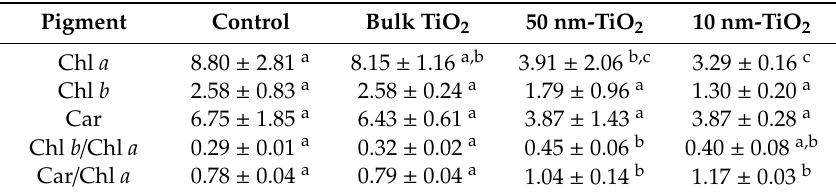
Table 1. Effects of three sizes of TiO 2 particles on the pigment of S. obliquus after 72 h exposure. Different letters following values in the same row represent significant difference (Tukey’s HSD, p < 0.05). Values are represented as means ± SD ( n = 3). Chlorophyll a (Chl a ), Chlorophyll b (Chl b ) and Carotenoid (Car) contents are expressed as 10 −13 g/cell.